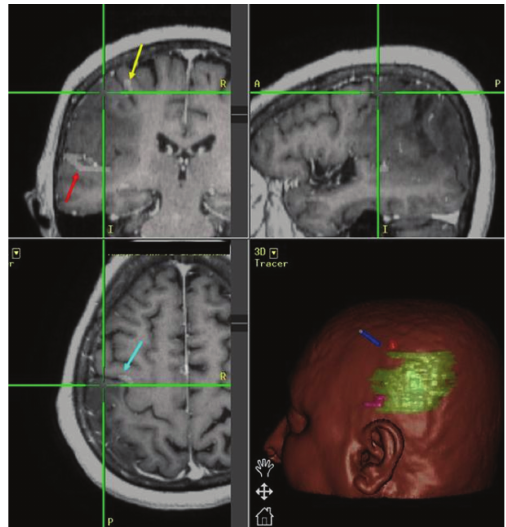
Figure 2: Neuronavigation workstation reproduced image showing superimposition of the fMRI data on the MR images. Red arrow shows the language area, yellow arrow shows right-hand motor area, and blue arrow shows (R hand) activation just anterior to the central sulcus.